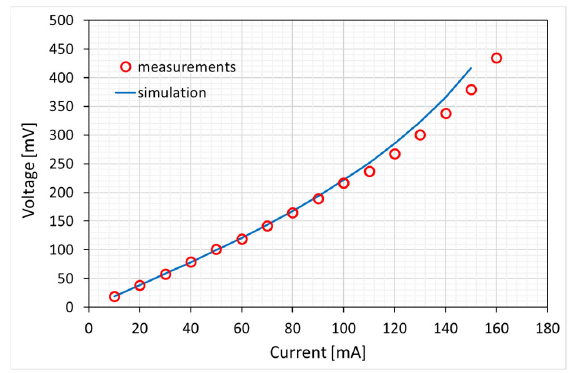
Figure 8. Voltage vs. current from measurements and simulation.